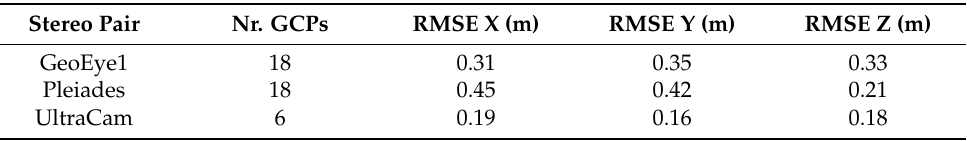
Table 3. Bundle adjustment results of the imagery orientation based on GCP measurements (root and airborne